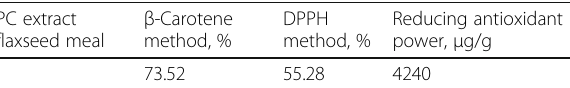
Table 1 Antioxidant activity of FM phenolic extracts as measured by three different methods